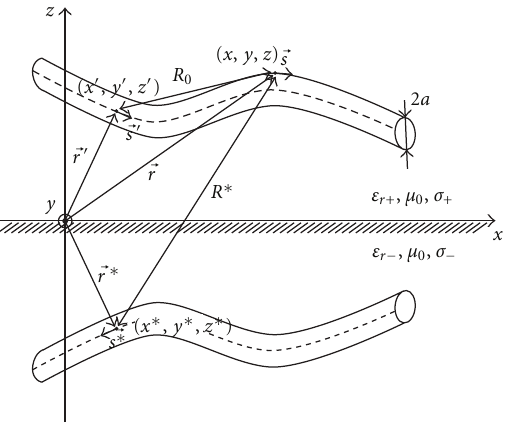
Figure 2: The wire of arbitrary shape and its